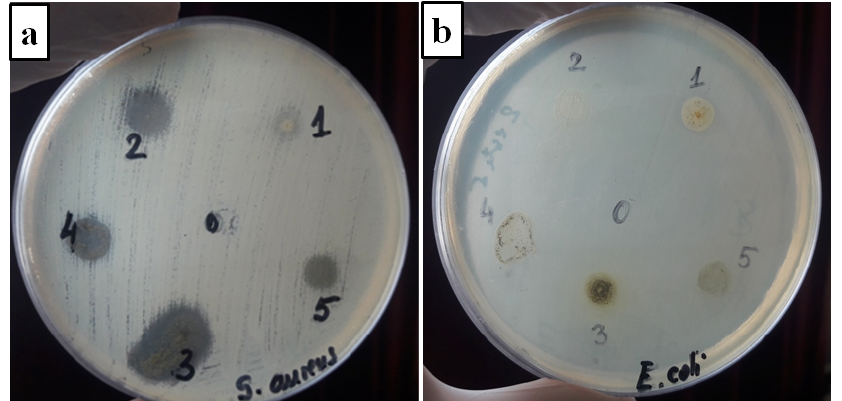
Figure 8. Inhibition zone diameters of PVA and PVA films loaded with plant extracts S. aureus ( a ); E. coli ( b ). 0, PVA; 1, PVA–LE; 2, PVA–VE; 3, PVA–SE; 4, PVA–CE; 5, PVA–ME. The inhibitory effect of prepared films varied with different bacteria. The poly(vinyl alcohol) film did not inhibit the growth of each strain, but the films with the plant extracts were very effective in suppressing the growth of the bacteria. The selected films exhibited better bacterial inhibition toward S. aureus than E. coli . This behavior comes from the differences between the cell wall structure of Gram-positive and Gram-negative bacteria [33]. Gram-negative bacteria such as E. coli have a lipopolysaccharide layer on the outer membrane, which prevents the penetration of antibacterial compounds [85,86]. The obtained inhibition zones were within 7–12 mm against E. coli bacteria and within 8–20